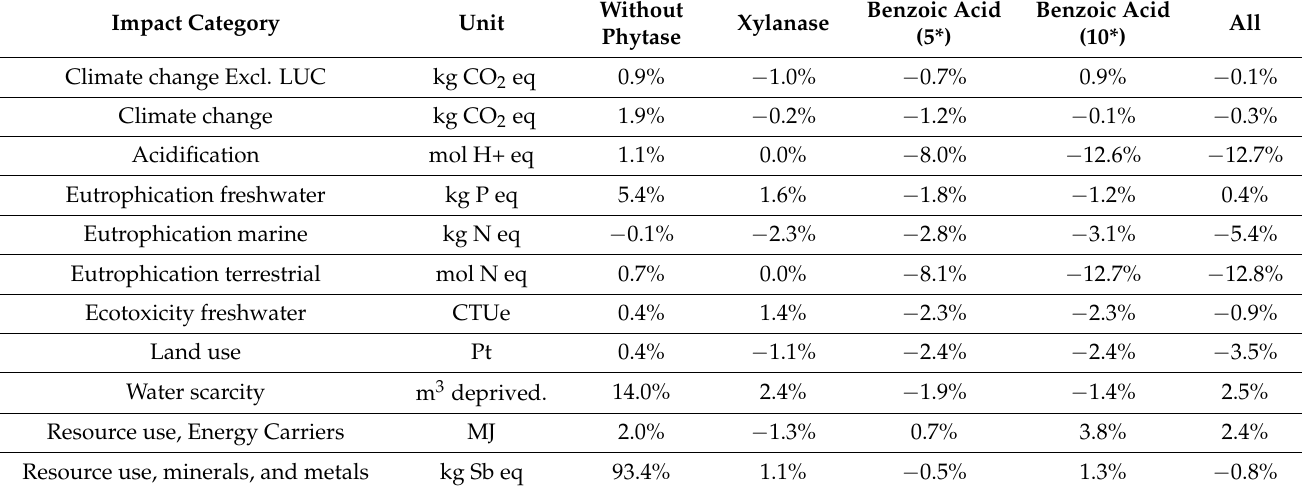
Table 1. Effects of using feed additives on pig diet to reduce negative environmental impacts: data adapted from